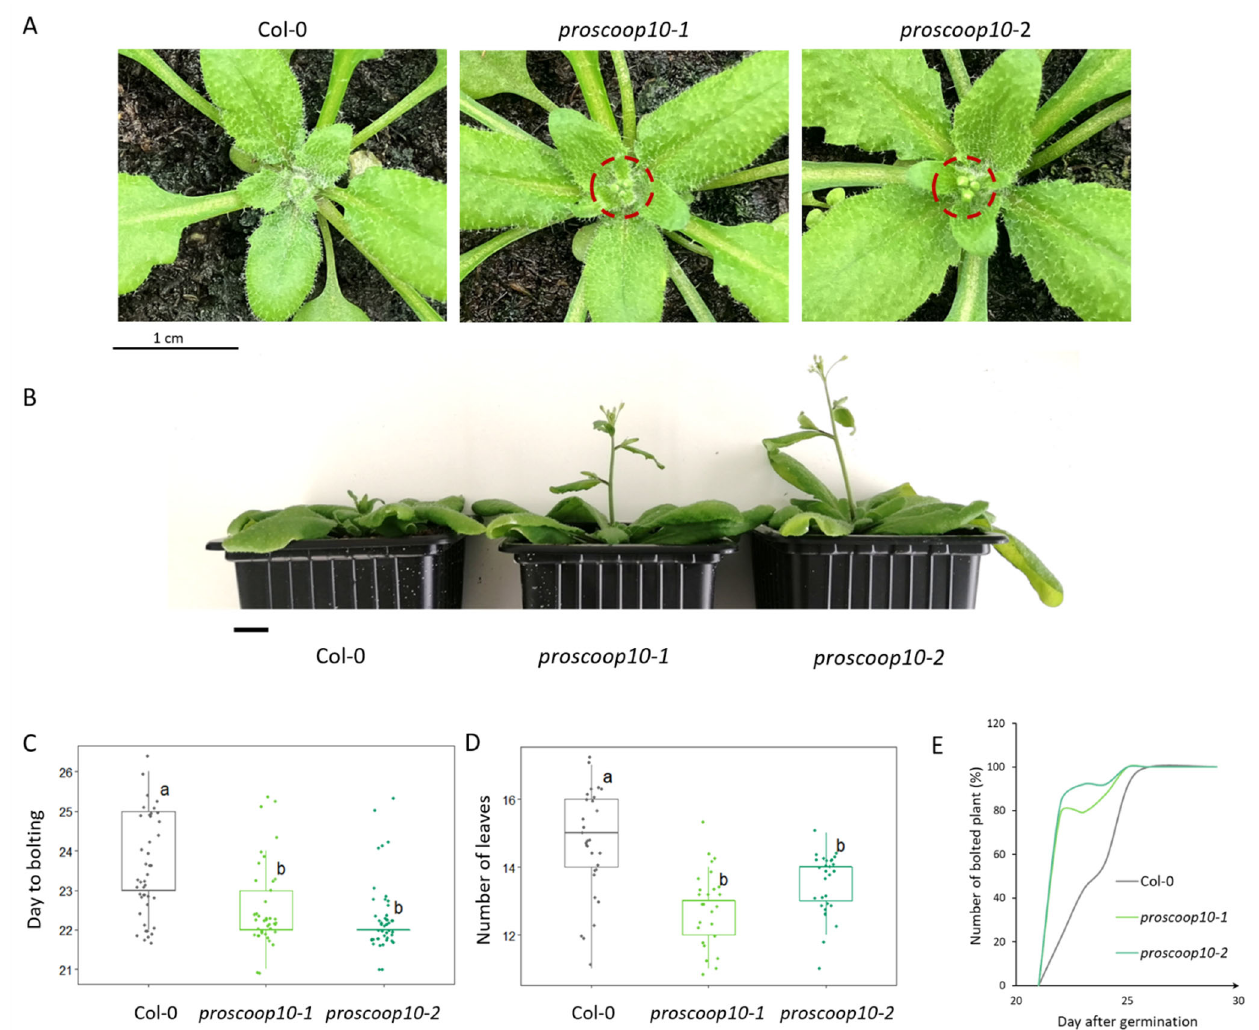
Figure 5. proscoop10 early ‐ flowering phenotype. ( A ) Bolted inflorescence of the proscoop10 mutant lines, 23nd day after germination. Red circles highlight the bolted inflorescences of the proscoop10 mutant lines compared to Col ‐ 0 on the same day. Scale bar = 1 cm. ( B ) Delay in stem development between mutants and WT due to the early flowering of the proscoop10 lines, 27th day after germination. Scale bar = 1 cm. ( C ) Average day to bolting for each genotype ( n > 40). ( D ) Average number of rosette leaves at the flowering time for each genotype ( n > 25). For ( C , D ), ANOVA and Tukey